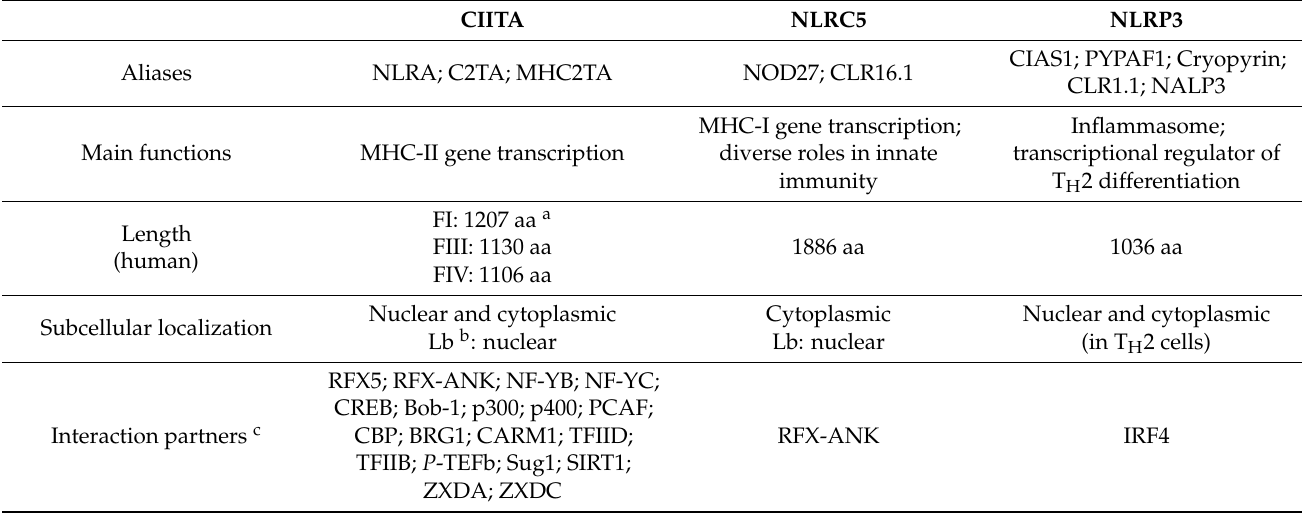
Table 1. Features of the NLR proteins CIITA, NLRC5 and